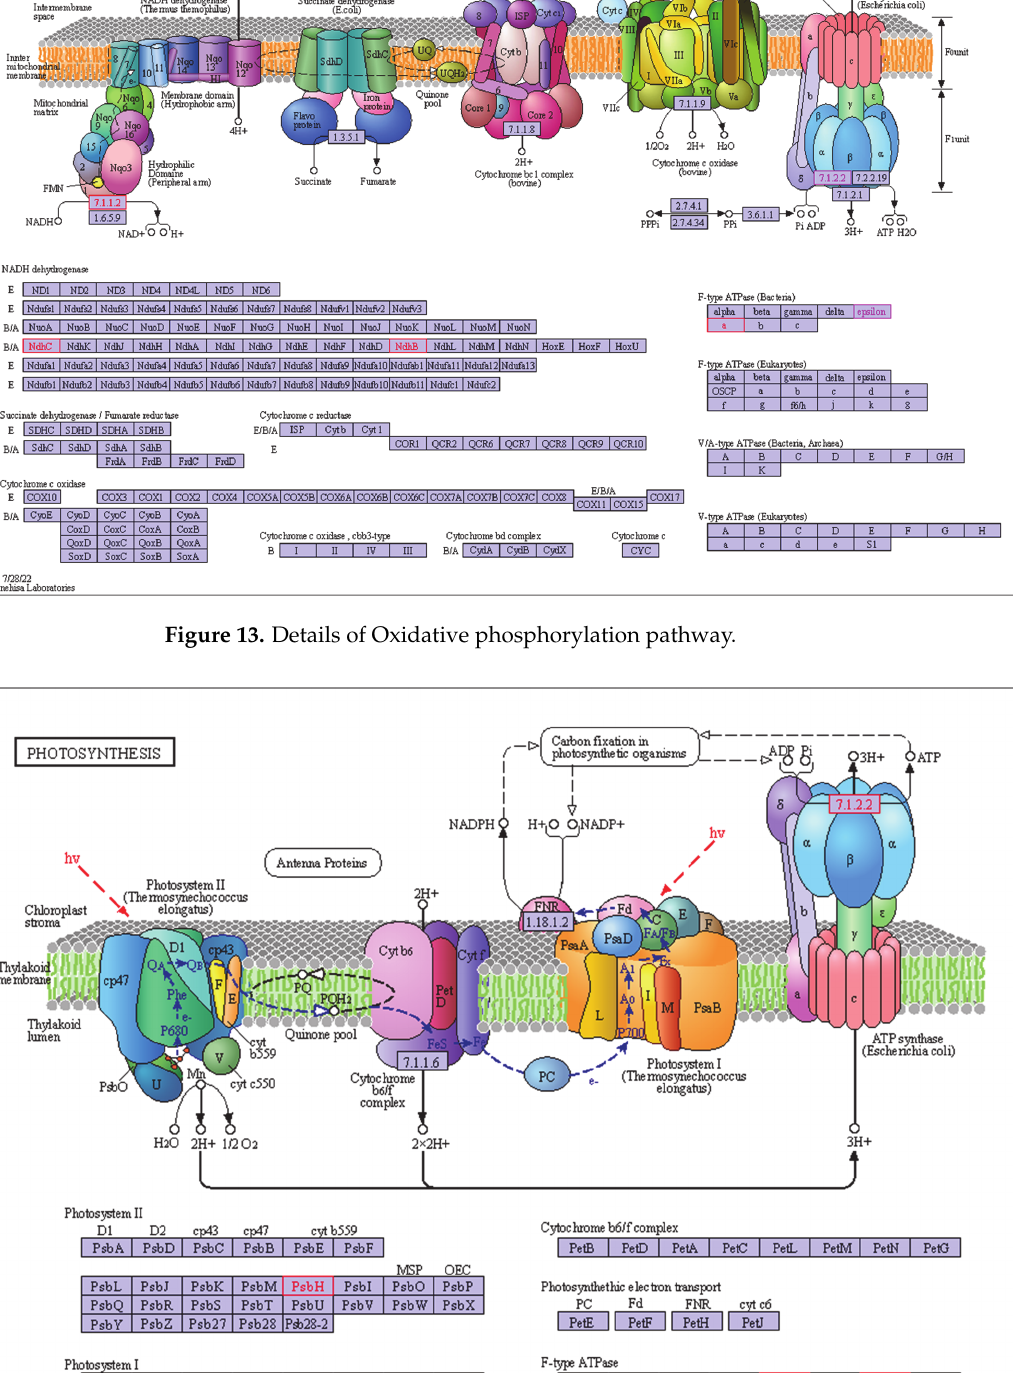
Figure 15. KEGG enrichment analysis of positive selection genes. A heat map based on expression levels of target genes at different times in the samples (Figure 16) showed that the expression level of rpl2 ‐ A was down ‐ regulated in December 2020 (cold conditions), and expressions of psbH , ndhB1 , atpI were up ‐ regulated 0